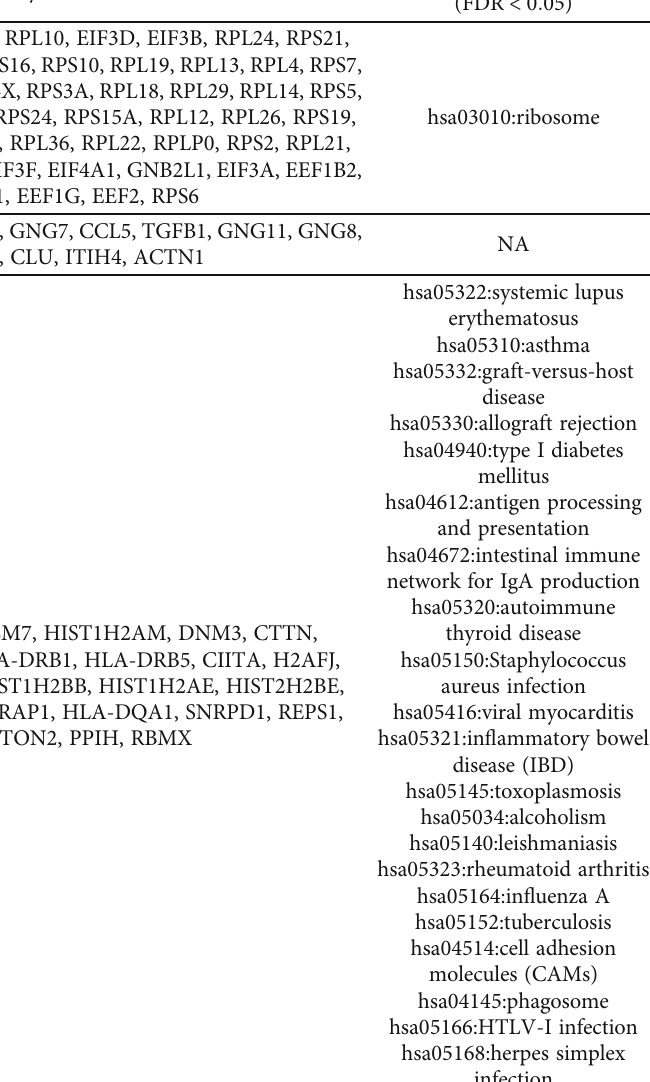
Table 2: Top scored three Molecular Complex Detection (MCODE) clusters and signi fi cantly enriched pathways. FDR: false discovery rate. MCODE Genes Interactions Gene